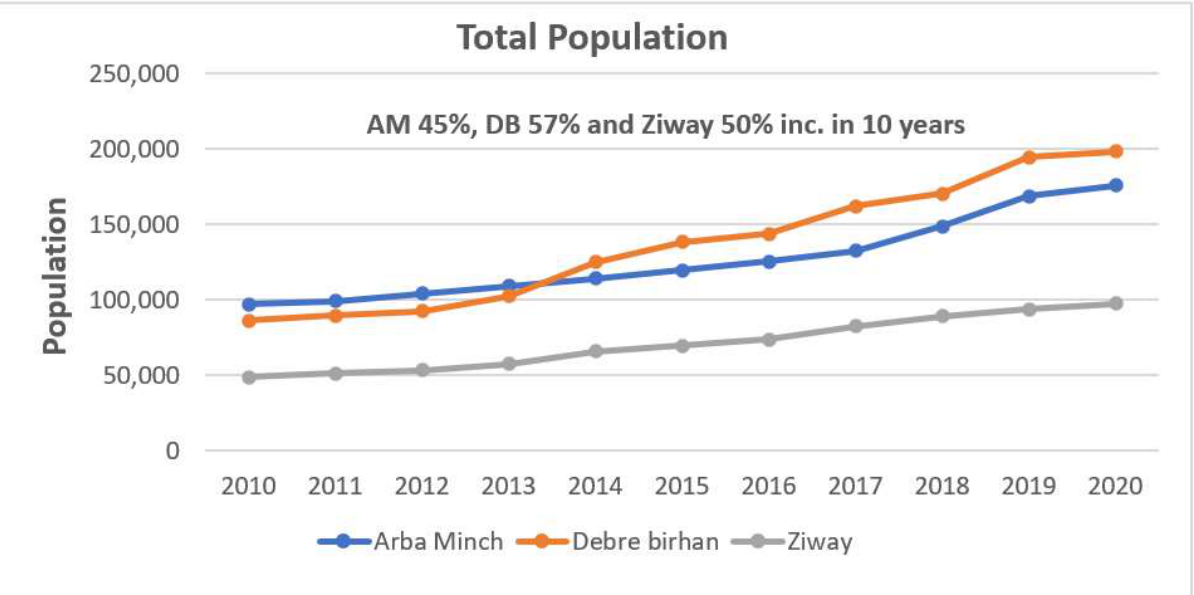
Figure 2. Population increase trend of the three towns for the last 10 years .